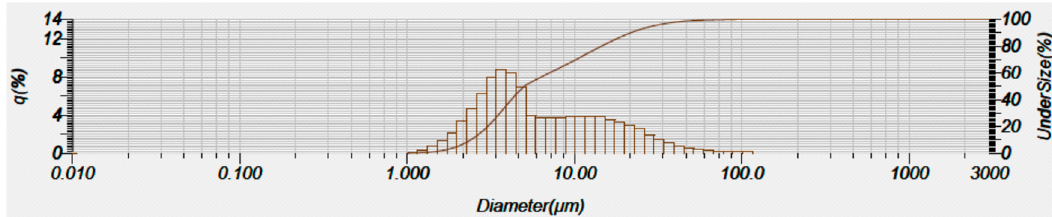
Figure 6. Normal distribution of FA.